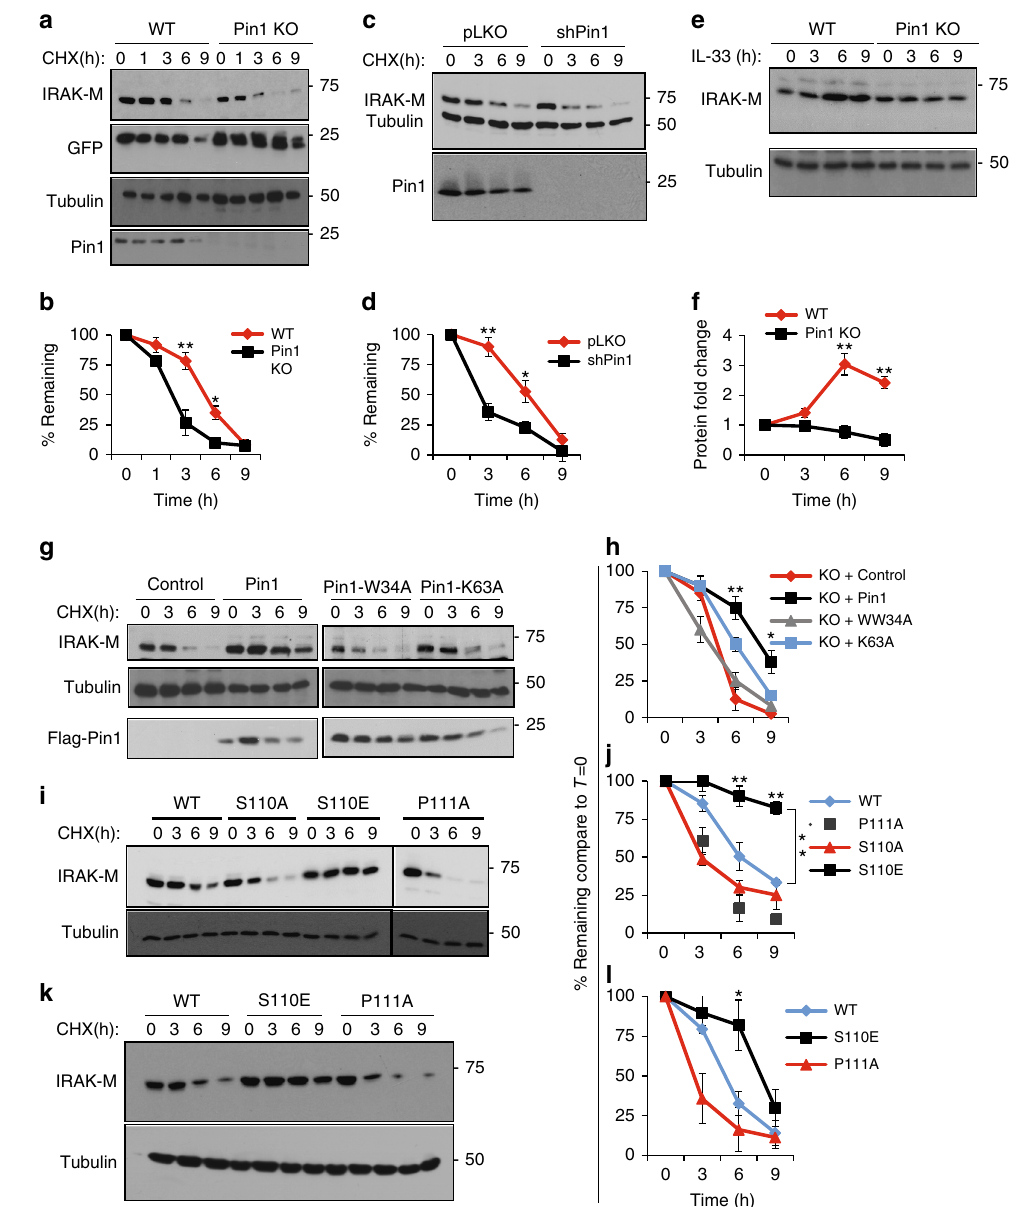
Fig. 4 PIN1 increases IRAK-M protein stabilization. a After IRAK-M and GFP were coexpressed in WT and PIN1 KO MEFs for 24 h, cells were split equally into 5 dishes. 24 h later cells were treated with cyclohexamide and harvested to monitor IRAK-M, GFP and PIN1 levels at the time points indicated. b Quanti fi cation of 3 independent experiments as in a . c WT MEFs stably expressing the TET on inducible short hairpin for PIN1 (shPin1) or pLKO as a control, were expressed with IRAK-M, followed by induction with Doxycycline for 18 h prior to the cyclohexamide chase. d Quanti fi cation of 3 independent experiments as in c . e BMDCs from WT or PIN1 KO mice were treated with IL-33 and the levels of IRAK-M were monitored at different time points after induction. f Quanti fi cation of 3 independent experiments as in e . g PIN1 KO MEFs were expressed with IRAK-M alone or in combination with PIN1 or its mutants W34A or K63A for 24 h, followed by the cyclohexamide chase to assay IRAK-M stability. h Quanti fi cation of 3 independent experiments as in g .